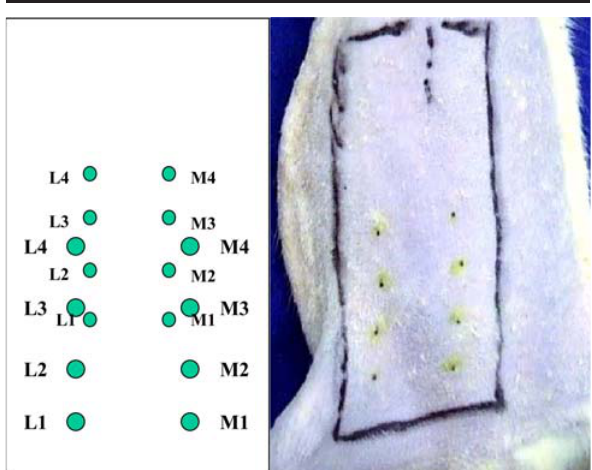
FIGURE 1 - Aspects of the draw of the flap. Left: the mold. Right: demarcation on the skin of the rat and the points for blood flow measurement.